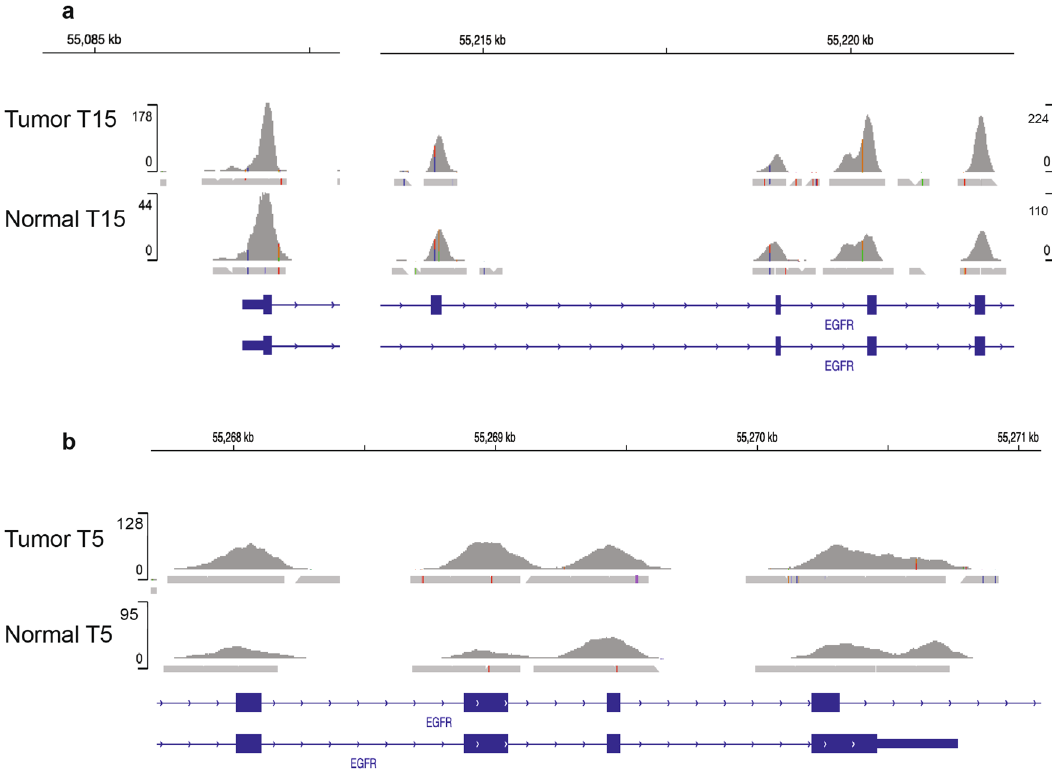
Figure 4. Amplified mutant EGFR in AA ESCC. ( a ) EGFR amplification in Sample T15 and corresponding normal sample sequencing readouts visualized in Integrative Genomics Viewer. ( b ) EGFR amplification in Sample T5 and corresponding normal sample sequencing readouts visualized in Integrative Genomics